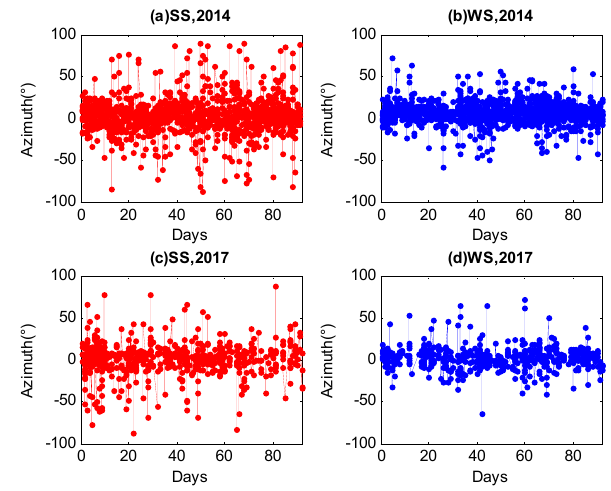
Figure 8. Propagation direction of ionospheric gravity waves (GWs) at 17:30–18:30 LT for the two solstices during the years of 2014 and 2017. SS represents the summer solstice and WS represents the winter solstice. Here, the scope of the azimuth is − 90° to 90°.